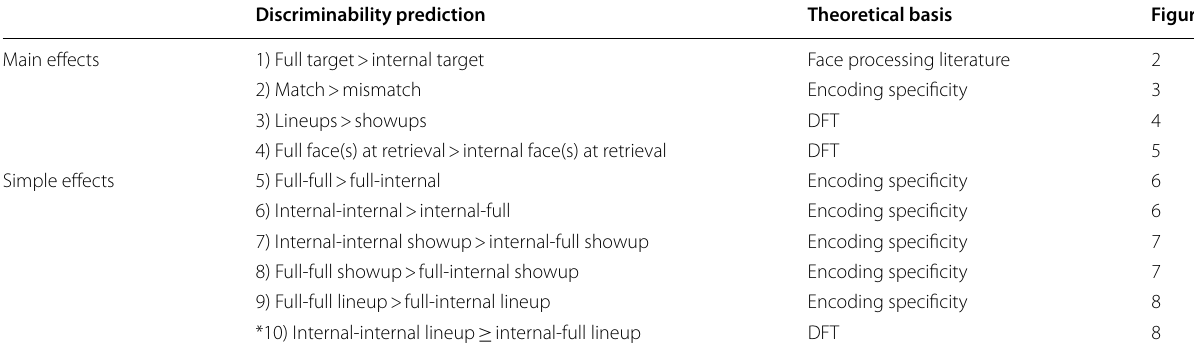
Table 3 Predictions derived from DFT as represented in Table